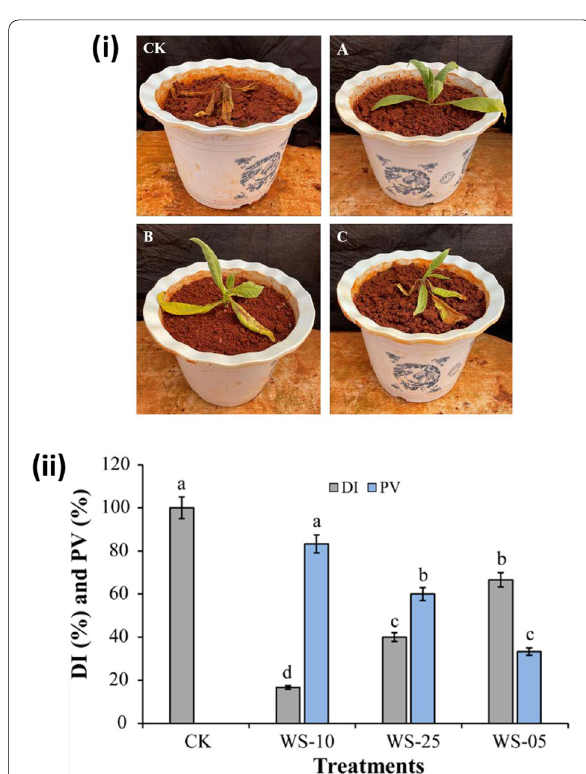
Fig. 2 Biocontrol efficacy of candidate Bacillus strains on tobacco bacterial wilt disease. ( i ); Symptoms produced on tobacco plants inoculated with bacterial wilt pathogen Ralstonia solanacearum WS-001 alone (CK) and in combination with each isolated strain WS-10 ( A ), WS-25 ( B ), and WS-05 ( C ). ( ii ); Disease incidence (%) and protective value (%). According to Duncan’s multiple range test, the significant difference among the treatments is shown by different small letters on the error bars, at P <